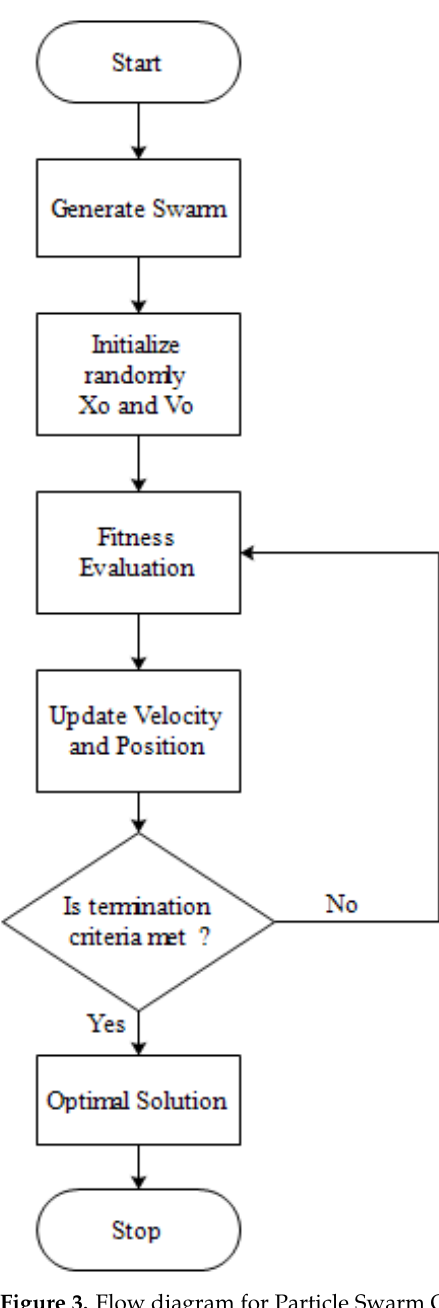
Figure 3. Flow diagram for Particle Swarm